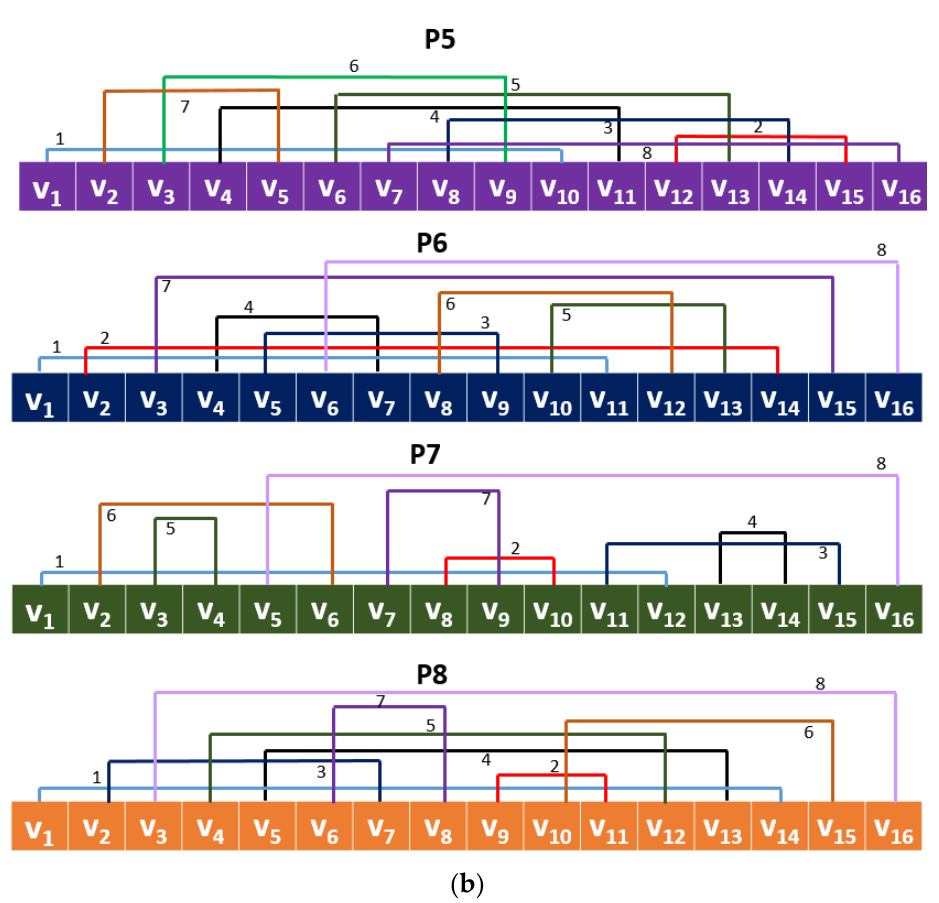
Figure 2. The created eight patterns using CGP17, where each pattern is named as P; by using each pattern, 256 features are extracted and our presented CGP17Pat uses these eight patterns together: ( a ) patterns 1–4; ( b ) patterns 5–8.